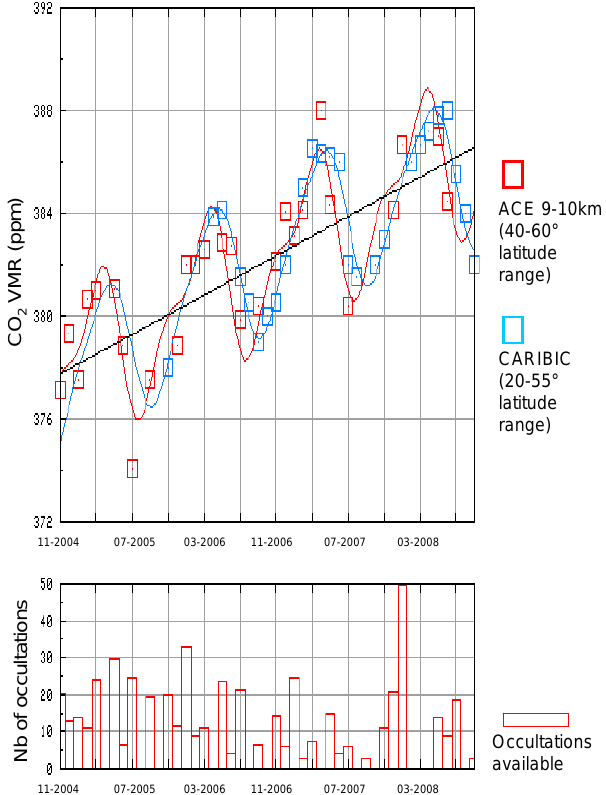
Fig. 5. Top: temporal evolution of CO 2 concentration (y-axis inppm) in the upper troposphere (9–10km). Blue boxes: ACE-FTS results for the 40 ◦ N–60 ◦ N latitude band; red boxes: CARIBIC measurements for the 20–55 ◦ N latitude band. The blue and red lines result from a curve fit using a harmonic polynomial (two har- monics). The slope of the best fit line corresponds to the mean growth rate during this time period: 1.9ppm . yr − 1 . Bottom: num- ber of ACE-FTS occultations used in the 9–10km altitude